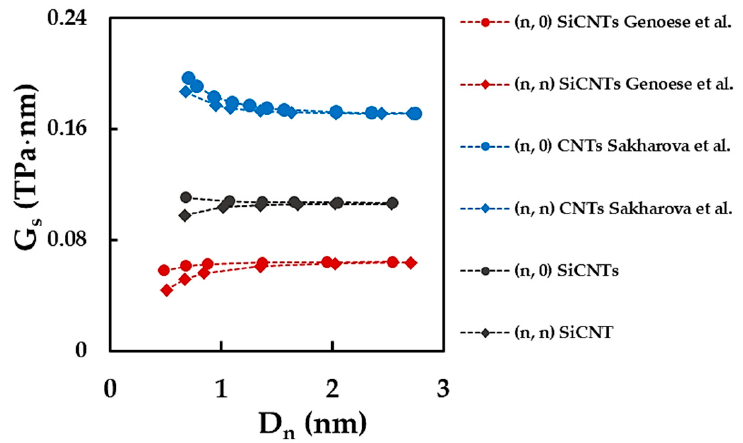
Figure 14. Comparison of the current results of the surface shear modulus, G S , of non-chiral SWSiC- NTs with those reported in the literature for SWSiCNTs [19] and SWCNTs [25]. In the case of the SWCNTs, G S was calculated using the shear modulus, G, results and assuming t n = 0.34 nm. The average value to which the surface of the shear modulus of the non-chiral SWSiCNTs converges is approximately 36% lower than that evaluated for the SWCNTs.